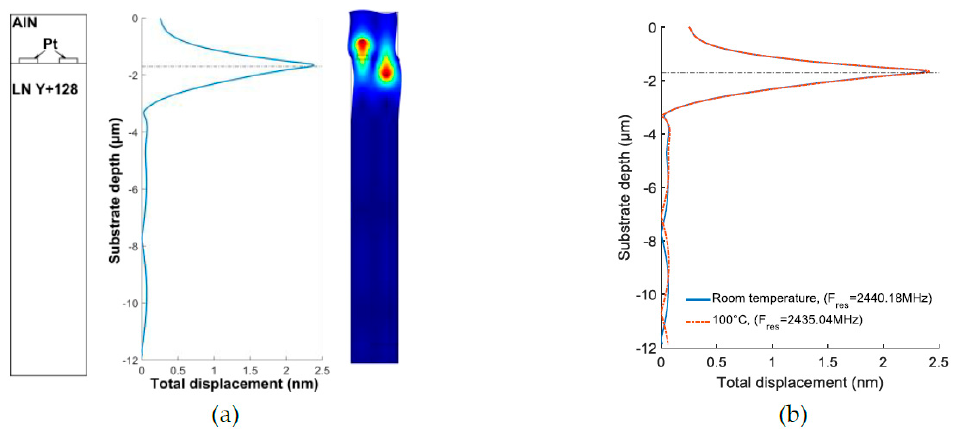
Figure 2. Guided mode in the S2 configuration. ( a ) at room temperature. ( b ) Comparison of the displacement fields, at room temperature and 100 °C. Both fields are almost identical.